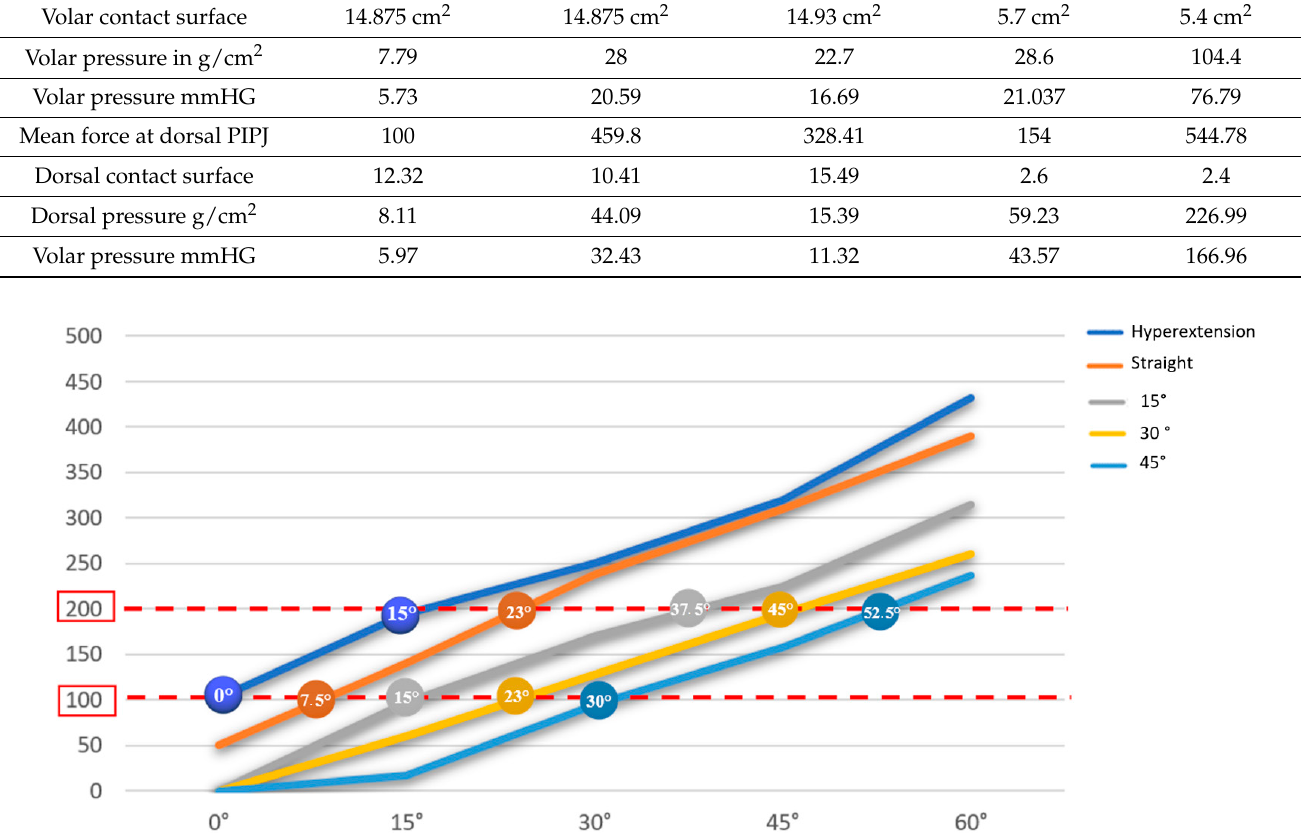
Figure 11. Therapeutic range of the ETDNO constructed at different angles. The values that are within the red range are the tolerable ranges for the patients in terms of